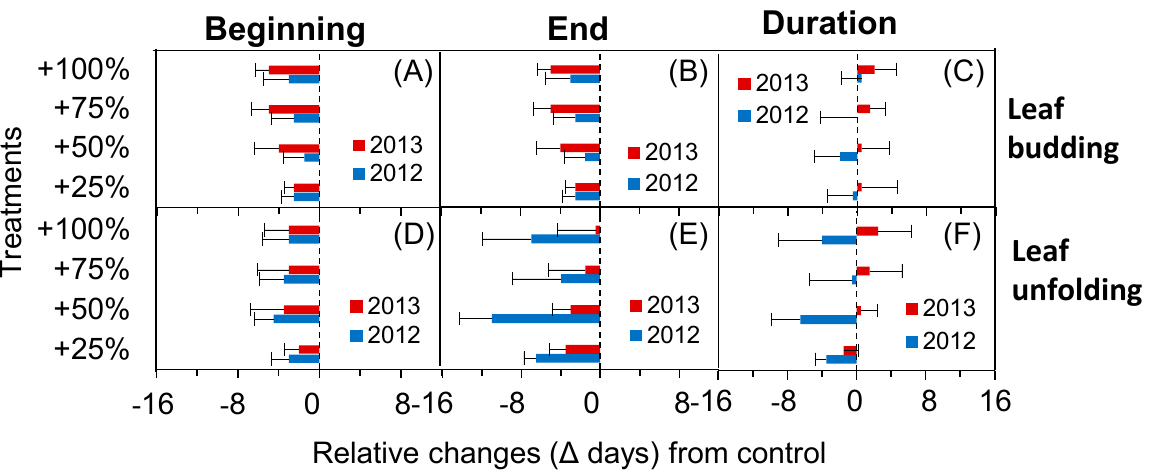
Figure 4. Effect of the simulated enhancement of precipitation on the time of the beginning ( A , D ), end ( B , E ), and duration ( C , F ) of the spring phenological events. Table 2. Duration of each phenological period under different treatment conditions 1 in 2012 and 2013 (means ± SE). Spring Phenology Autumn Phenology Year Treatments Leaf Budding Leaf Unfolding Leaf Senescence Leaf Fall